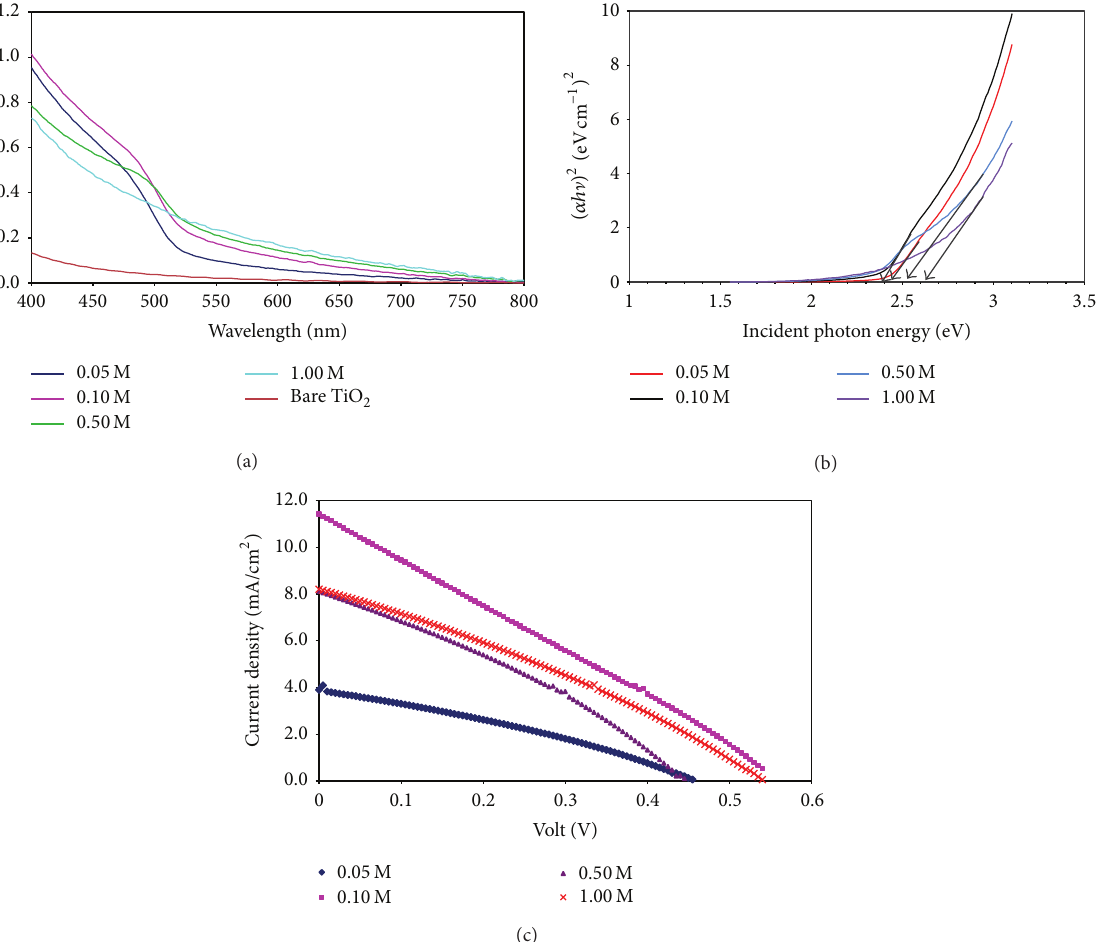
Figure 2: (a) UV-vis spectra, (b) Tauc plot, and (c) J-V curves of QDSSCs for CdS QDs prepared using different precursor